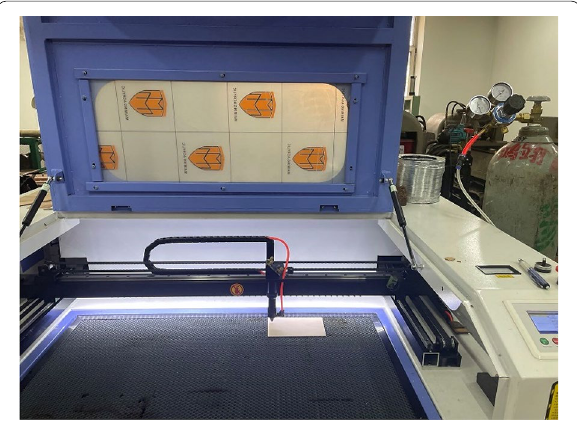
Fig. 7 Gas-assisted laser processing